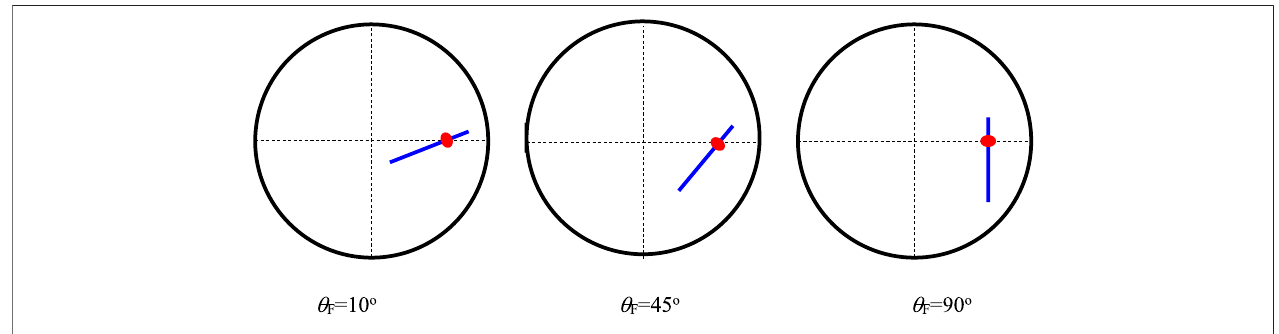
FIGURE 16 | Fracture angle physical model.